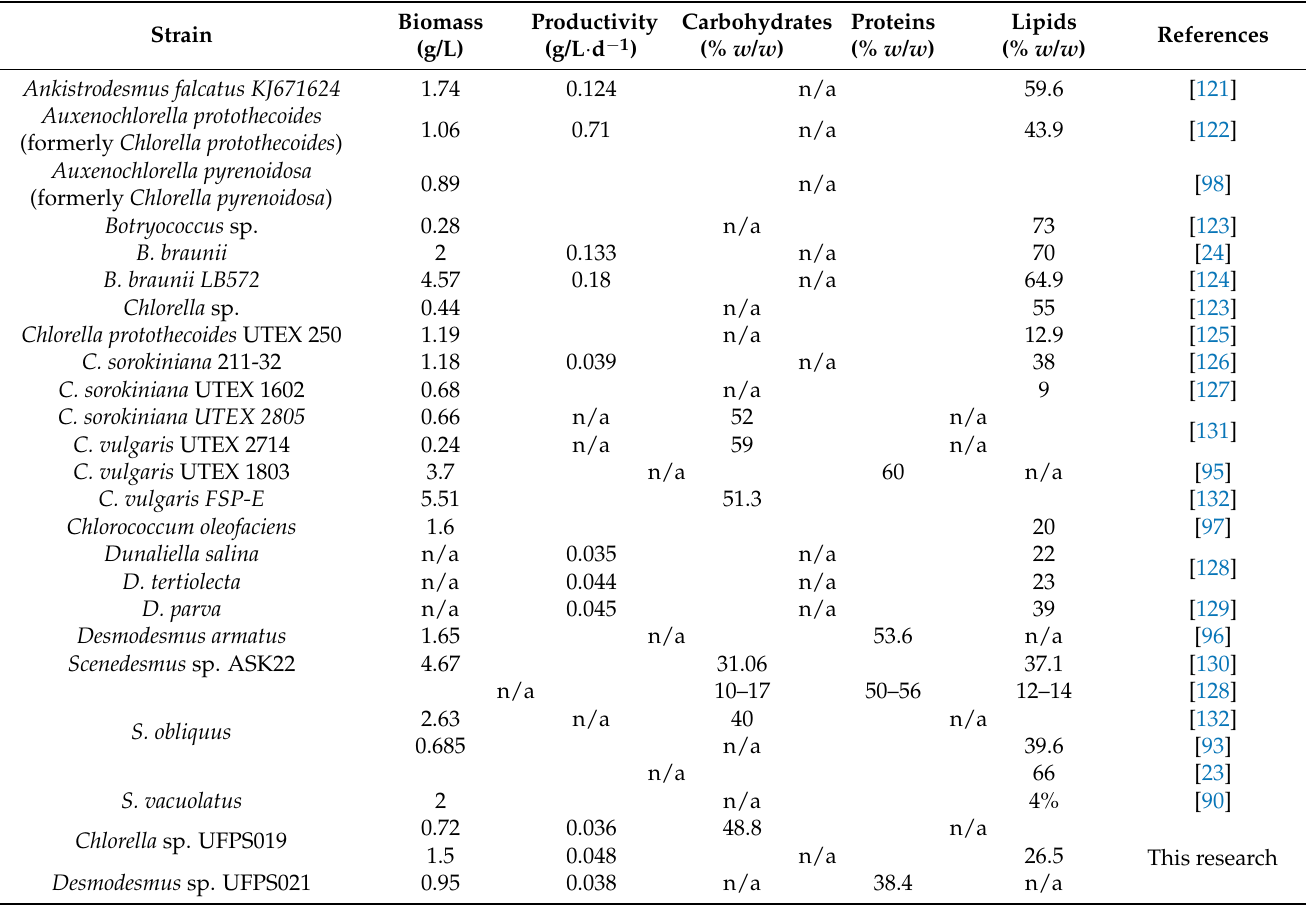
Table 5. List of reported algal strains with culture media optimized via design of